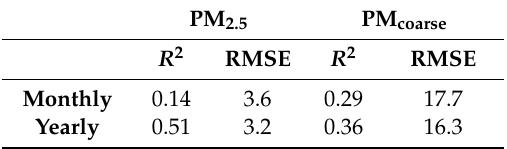
Table 6. Comparison of predictions with regulatory monitors, by